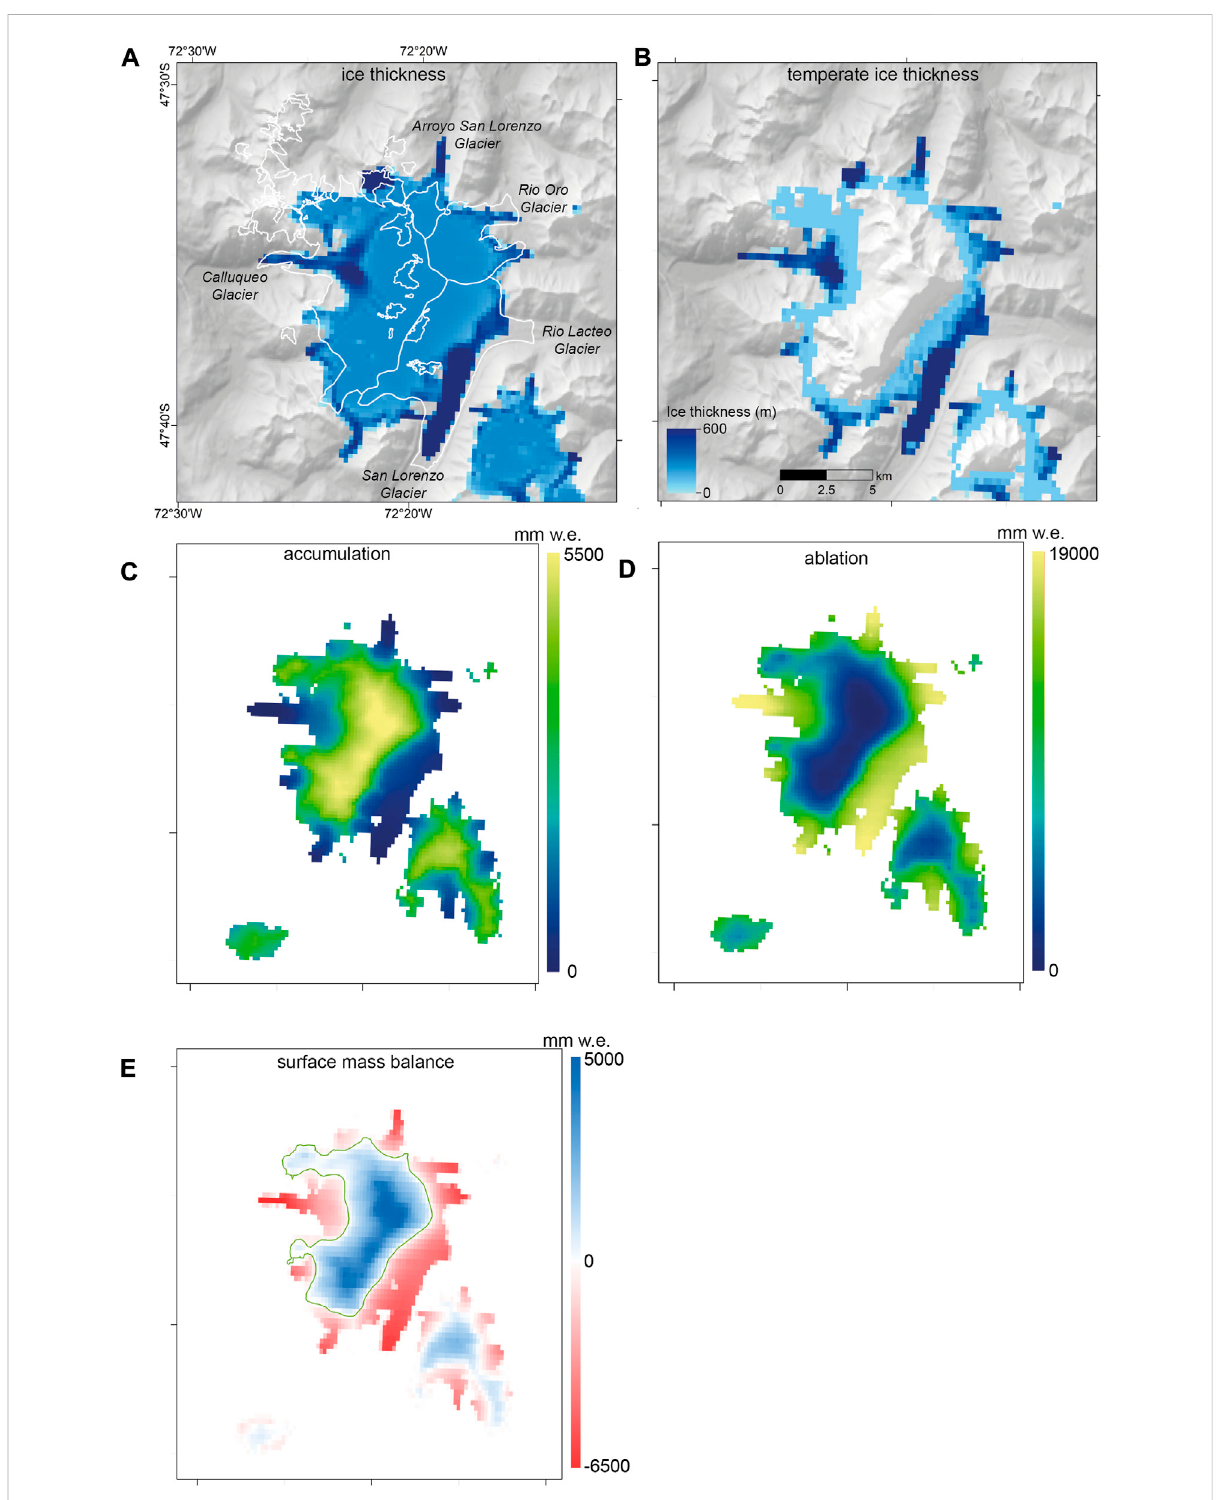
FIGURE 7 Total ice thickness (A) and temperate ice thickness (B) for the best- fi t scenario of the modelled MSL ice cap. The white lines in (A) denotes the present-day ice extent and glacier catchment divides. Spatial distribution of annual accumulation (C) , ablation (D) and surface mass balance (E) across the MSL ice cap. The green line in (E) denotes the Equilibrium Line. Tick marks represent latitude and longitude (as shown in panel